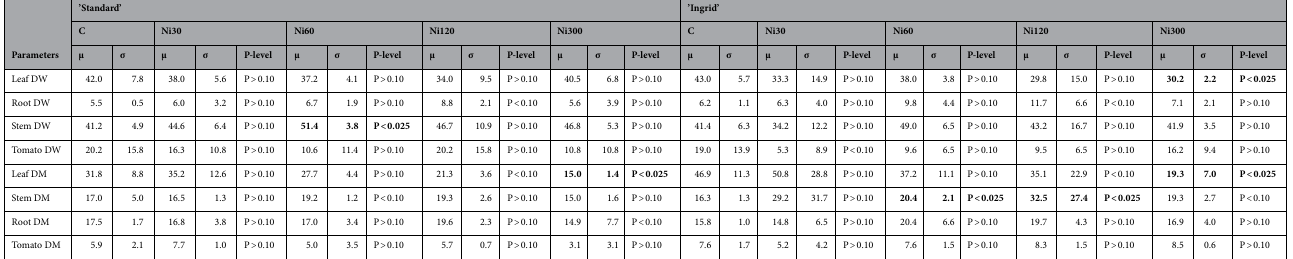
Table 4. Kolmogorov–Smirnov two-sample test for comparison of controls (C) with the other Ni treatments (Ni 30, Ni 60; Ni 120; Ni 300 mg kg −1 , respectively) with compared to mean μ and standard deviation σ considering plant parameters and the two cultivars used (’Standard’ and ’Ingrid’). P-levels are reported. Significant differences and significant P-levels marked in bold. Parameters’ legend: dry-weight: DW; dry- matters: DM.